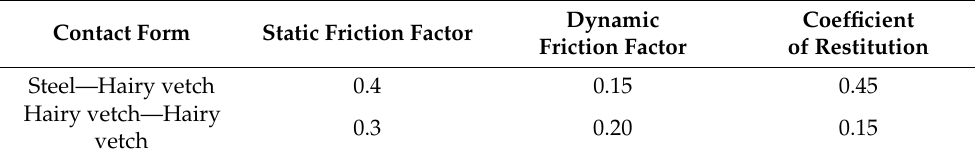
Figure 14. Stems model of hairy vetch. Table 3. Mutual contact factors of